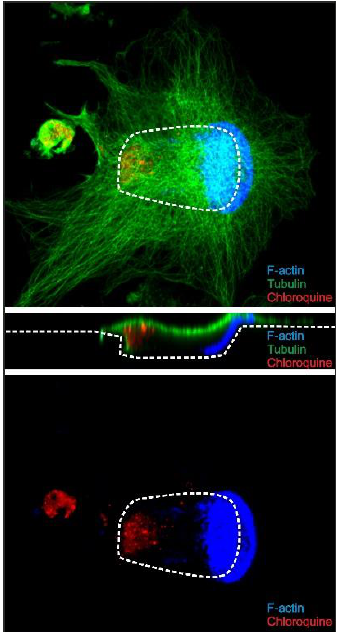
Figure 6. Chloroquine accumulates towards the rear end of trench-making OCs. Chloroquine immunoreactivity is shown in red, f-actin in blue, and tubulin in green. Upper and lower images are views looking down on the OC from above the bone surface, whereas the center image shows a longitudinal cross-section of the same OC. Dashed white lines show the edge of the resorption cavity (top and bottom images), while it shows the bone surface in the center image. The width of all three images is 141.4 µ m.